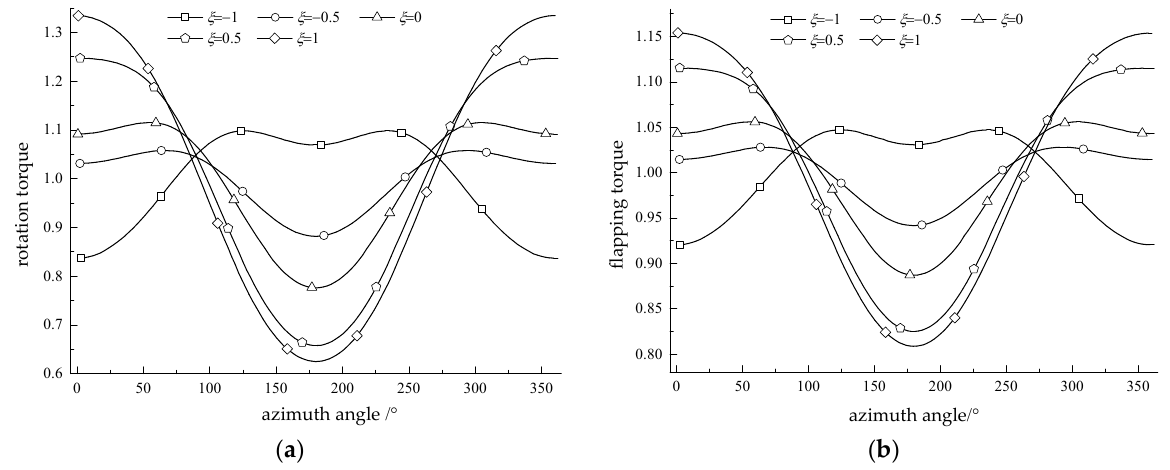
Figure 12. Variation of the rotation torque and flapping torque of the blade as a function of the azimuth for different LLJ heights. ( a ) rotation torque. ( b ) flapping torque.